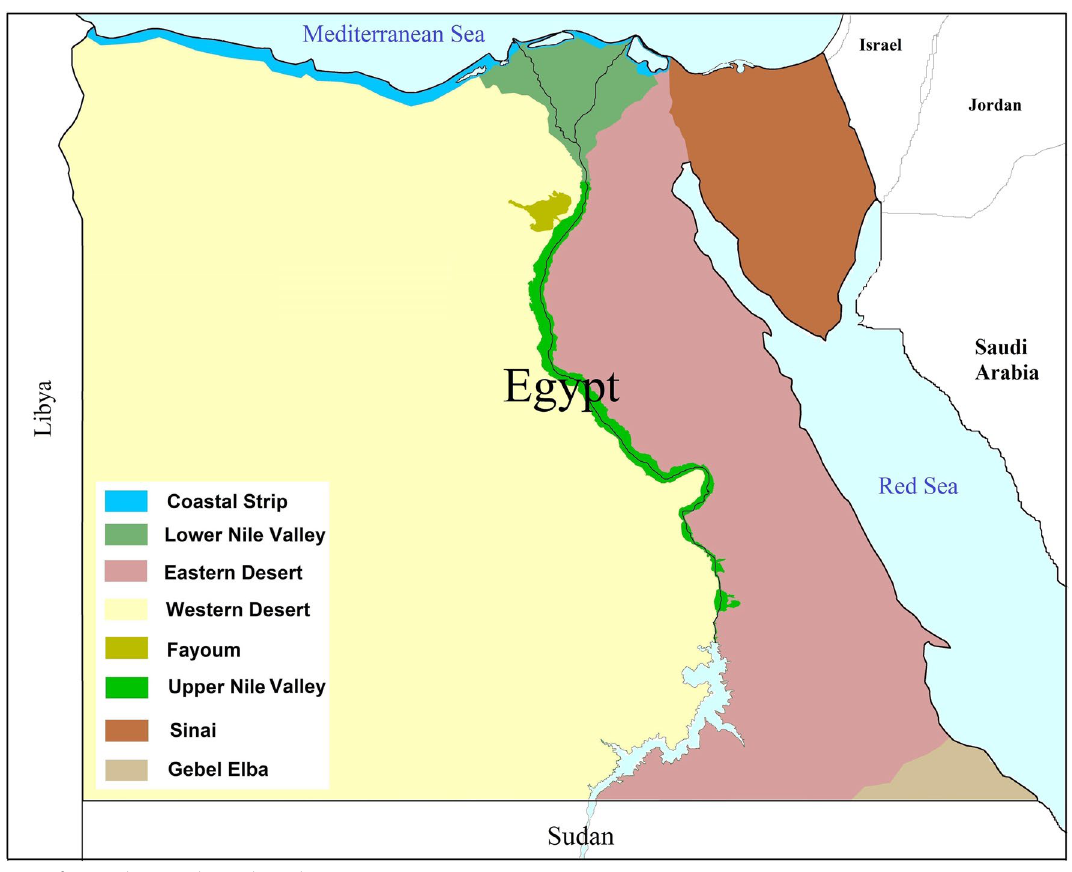
Fig. 1 Map of Egypt showing the ecological